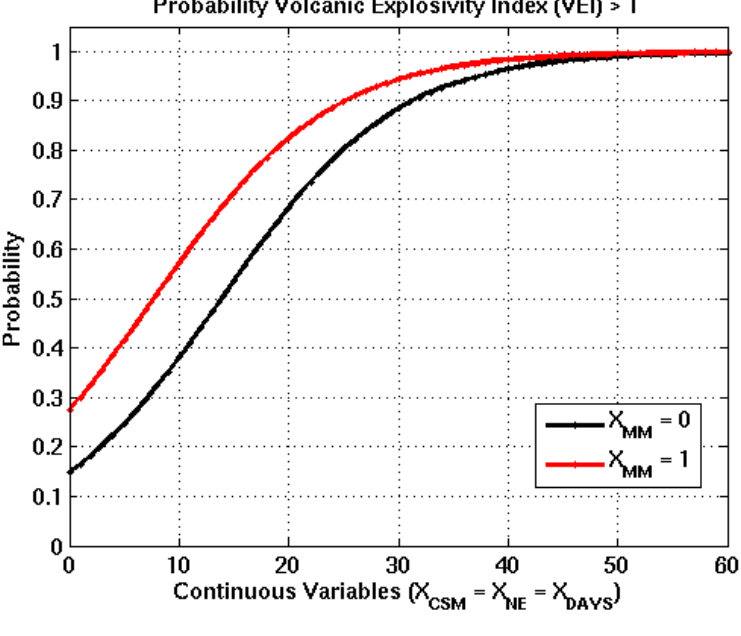
Figure 4. Logistic functions derived from bootstrapping process for the intensity node, where the black and red curves represent X from 0 to 1 increases the probability of occurrence by 0.13, which is the difference between the black and red curves when all continuous input variables are equal to